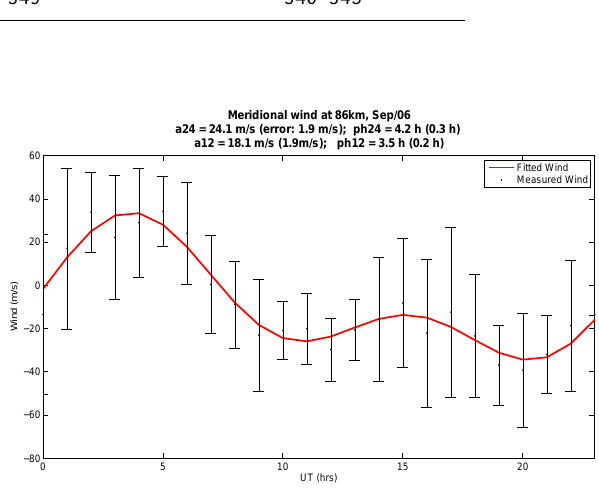
Fig. 1. Hourly averaged JASMET measurements (black dots) and tidal fits (red curve) from 0 to 23h in UT for the meridional winds at 86km in September 2006. The errors from the fit procedures are included in parenthesis. The vertical bars indicate the standard deviation of the hourly wind data.